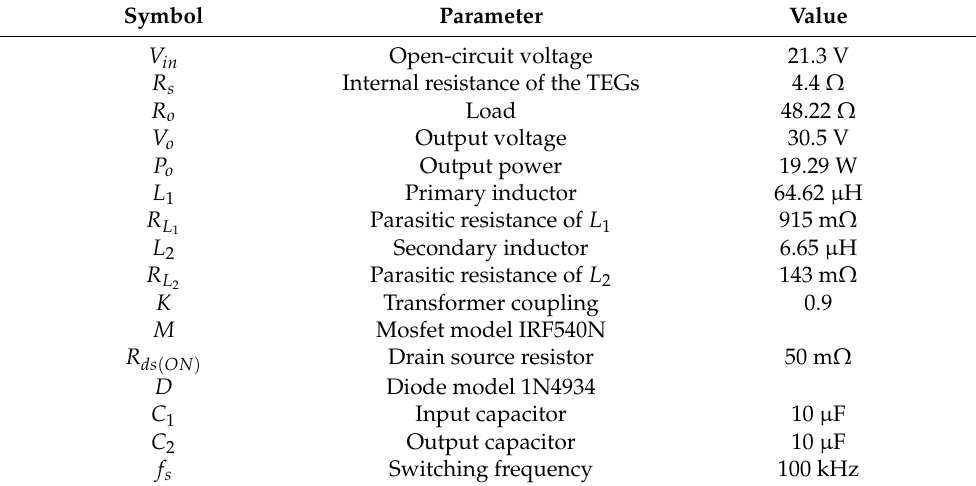
Table 1. Design Parameters of the TEG module and converter.